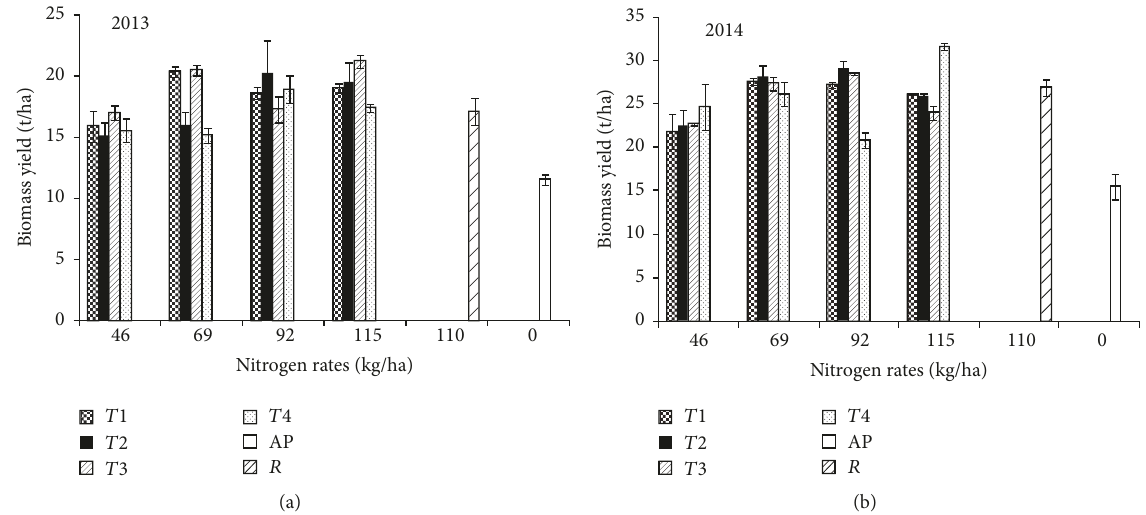
Figure 4: The effect of N rate and time of application on biomass yield of maize in the 2013 and 2014 rainy seasons.